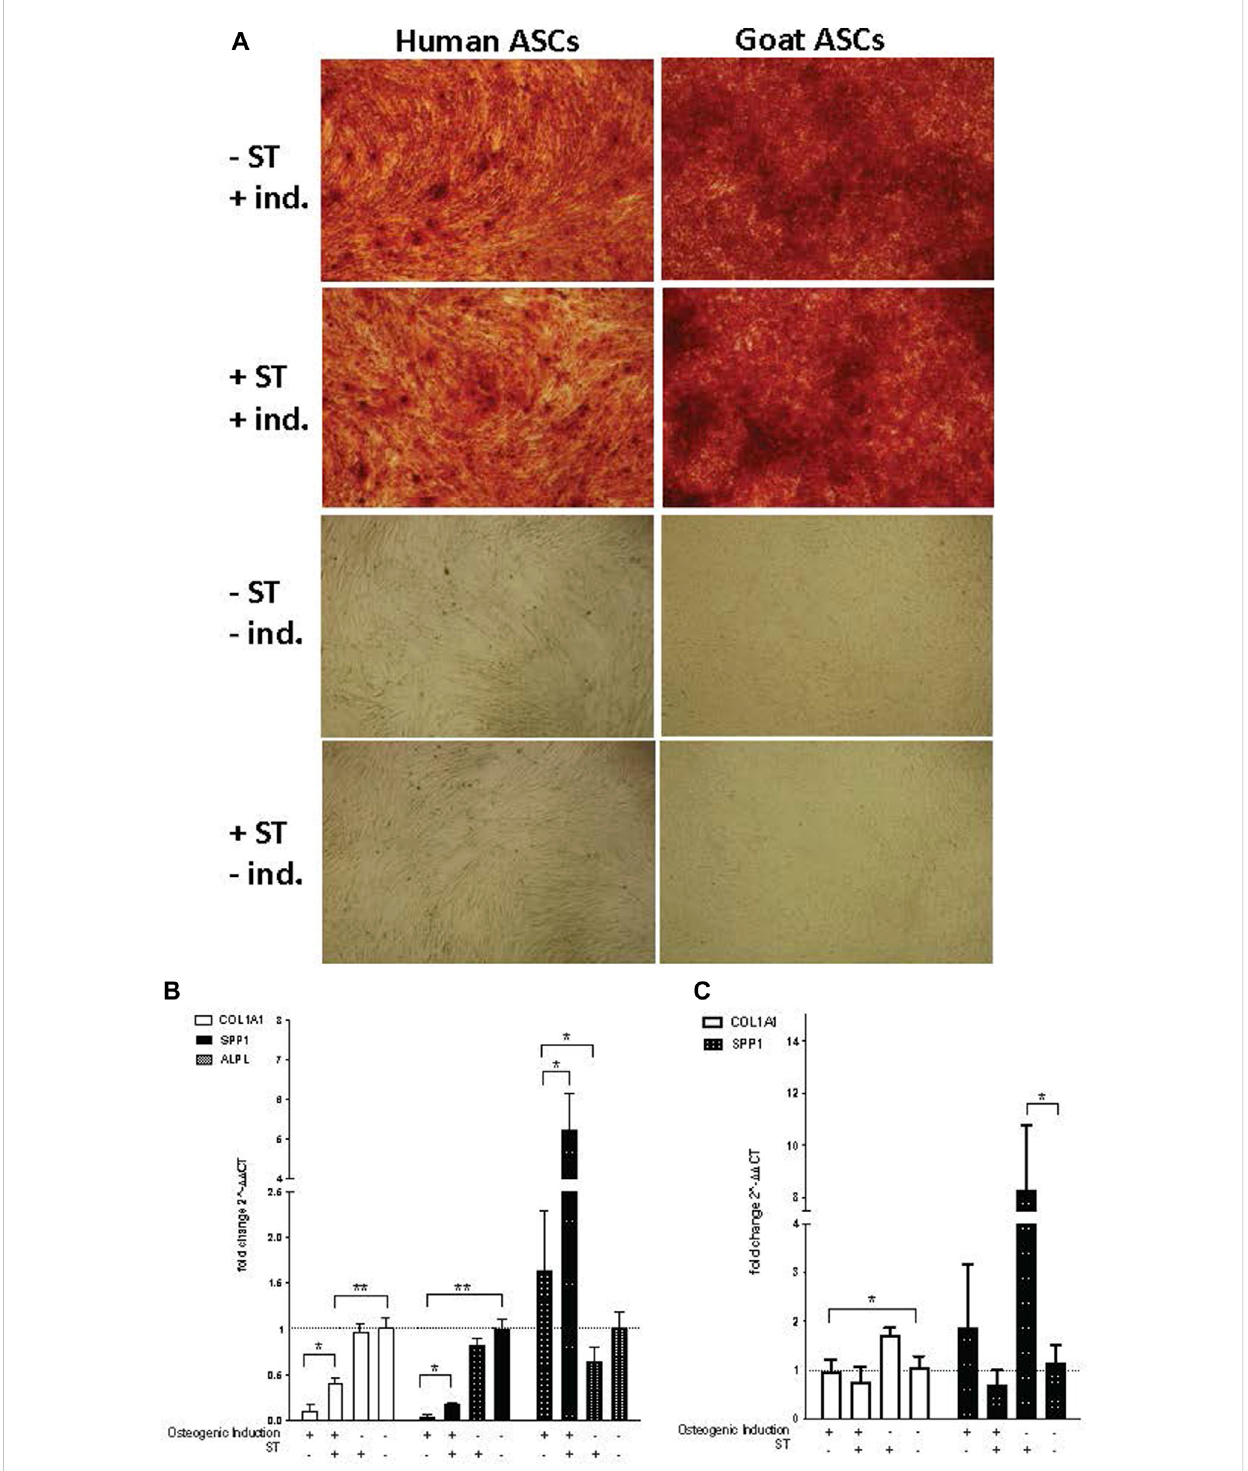
FIGURE 7 Osteogenic induction. Representative images are shown in phase contrast at ×40 magni fi cation. (A) Alizarin Red S staining of osteogenic differentiationinASCspost-microbialassociation.hASCswereculturedinosteogenicdifferentiationmediumfor14 days,whereasgASCsfor21 daysand stained with Alizarin Red S. ASCs cultured in osteoinductive medium stained positive for calcium but did not stain when cultured in control medium, regardless of S.T treatment. Expression of osteogenic markers in ASCs post-microbial association were analyzed via quantitative PCR analysis of COL1A1, ALP and OPN gene expression in (B) human and (C) goat ASCs induced with osteogenic differentiation medium and/or